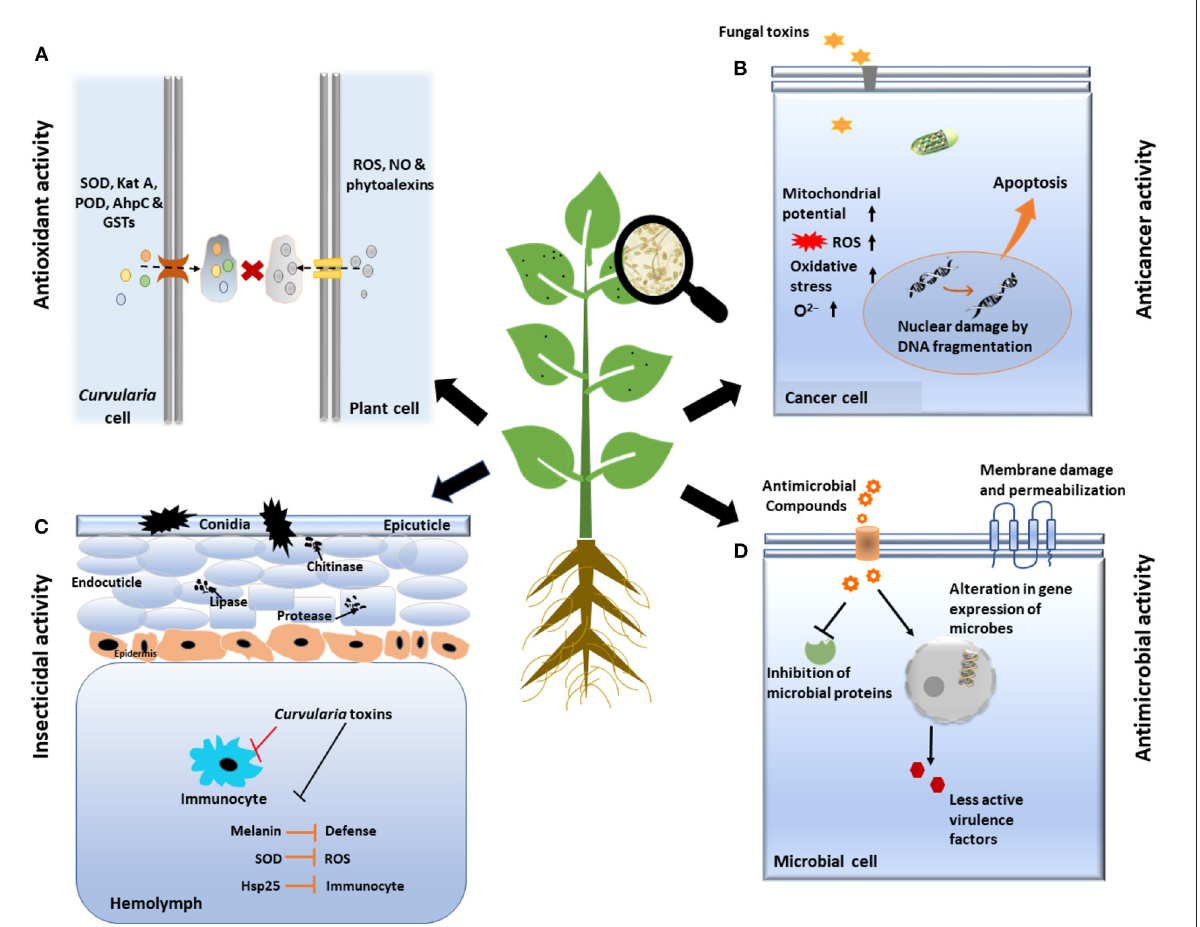
FIGURE5 Schematic representation of various biological activities of Curvularia spp. (A) Anti-oxidant activity: Fungus secreted many anti-oxidative enzymes such as superoxide dismutase (SOD), catalase, peroxidase, etc. which counteracts to reactive oxygen species (ROS), generated by immune system of host plant. (B) Anti-cancer activity: Toxin secreted by fungus induced program cell death/apoptosis of cancerous cell by various processes like changing the membrane potential of mitochondria, DNA fragmentation, etc. (C) Insecticidal activity: Curvularia toxins suppress the function of insect immunocytes and inhibits immune system of insects by producing virulence factors like Melanin, Hsp25, etc. Finally, it increases level of enzymes like lipase, chitinase, protease which ultimately cause death of insect cells. (D) Anti-microbial activity: Curvularia spp. Secrets some of anti-microbial compounds, that shows antagonism against microbes by damage and permeabilization of membrane, inhibition of microbial proteins and by altering the gene expression of